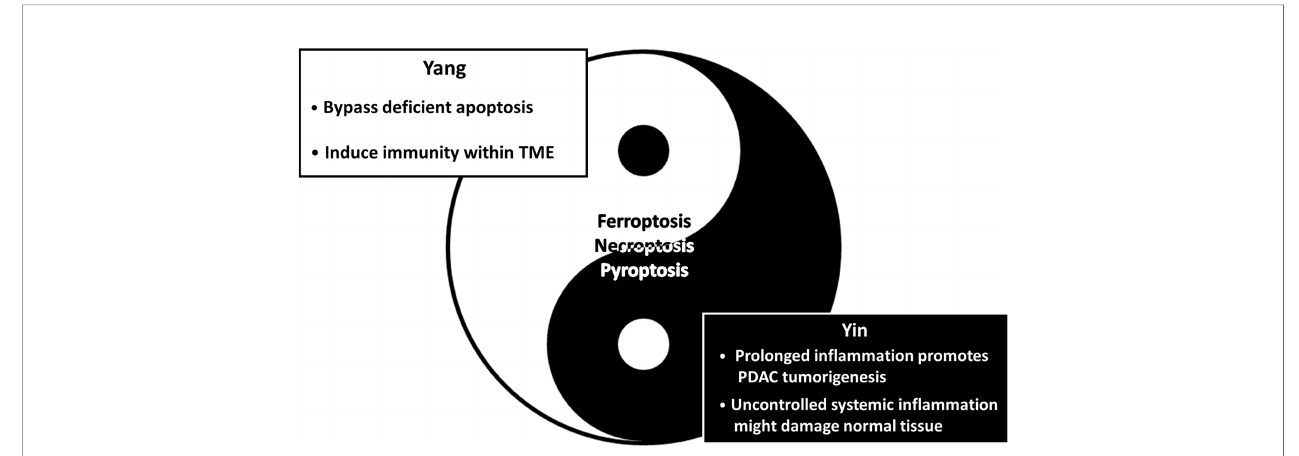
FIGURE 4 | The Yin-Yang theory of inducing nonapoptotic cell death in PDAC suppression. The schematic diagram illustrates the advantages (Yang/Light side) and the disadvantages (Yin/Dark side) of nonapoptotic cell death in PDAC treatments. Simply put, induction of nonapoptotic PCD is promising in PDAC treatment; however, it possibly brings about unwanted clinical outcomes simultaneously. On the one hand, it is capable of eliminating chemoresistant PDAC driven by an aberrant apoptosis mechanism by inducing alternative PCD. Furthermore, ferroptosis, necroptosis and pyroptosis are immunogenic forms of PCD characterized by the release of DAMPs, which probably trigger antitumor immunity. On the other hand, emerging evidence suggests that immunomodulators secreted from immunogenic PCD facilitate immunosuppression. Additionally, uncontrolled systemic in fl ammation might compromise adjacent normal tissues instead. Collectively, further investigation is urgently